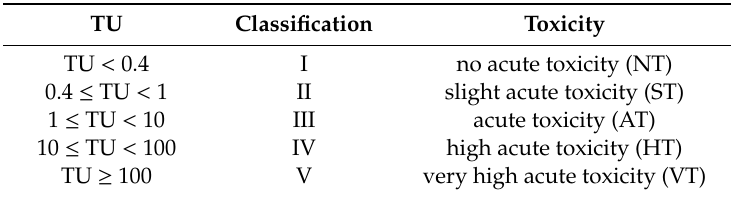
Table 1. Toxicity classification